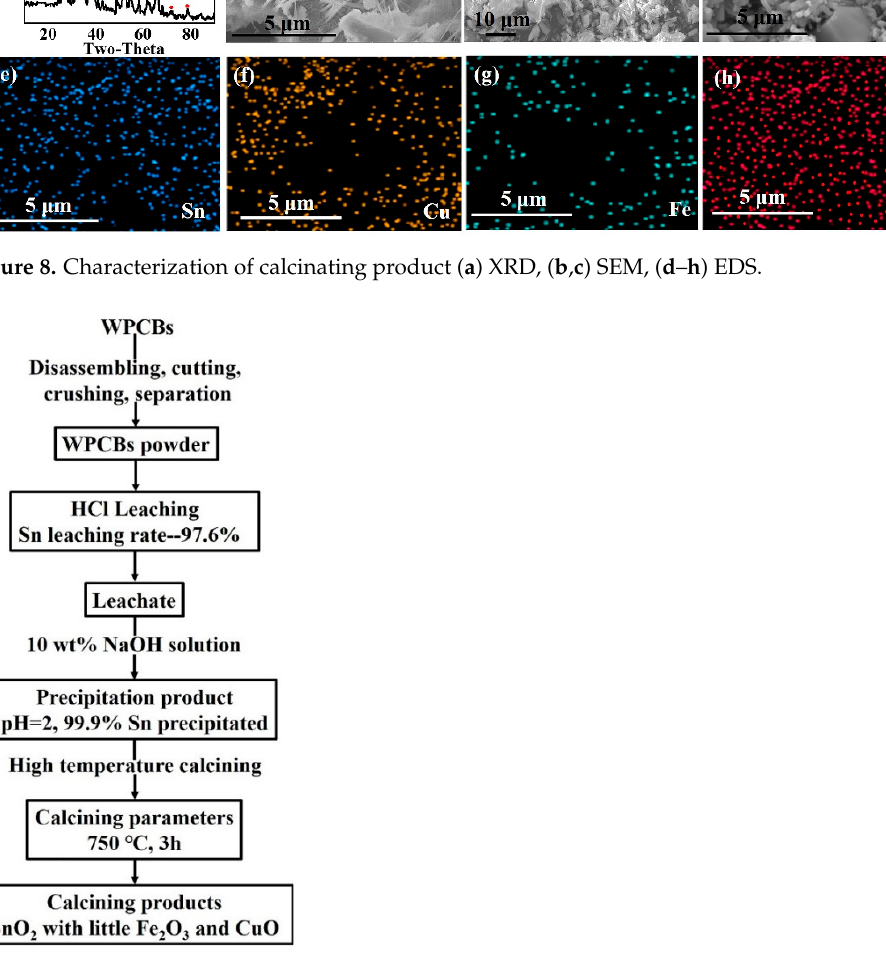
Figure 9. The flow sheet of Sn recovery process from WPCBs.